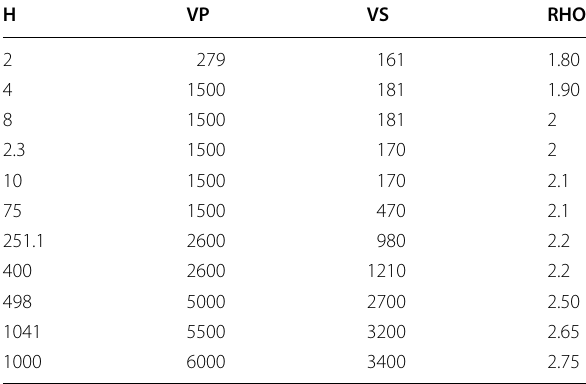
Table 1 Best-fit layered-earth model for the Kumamoto site,